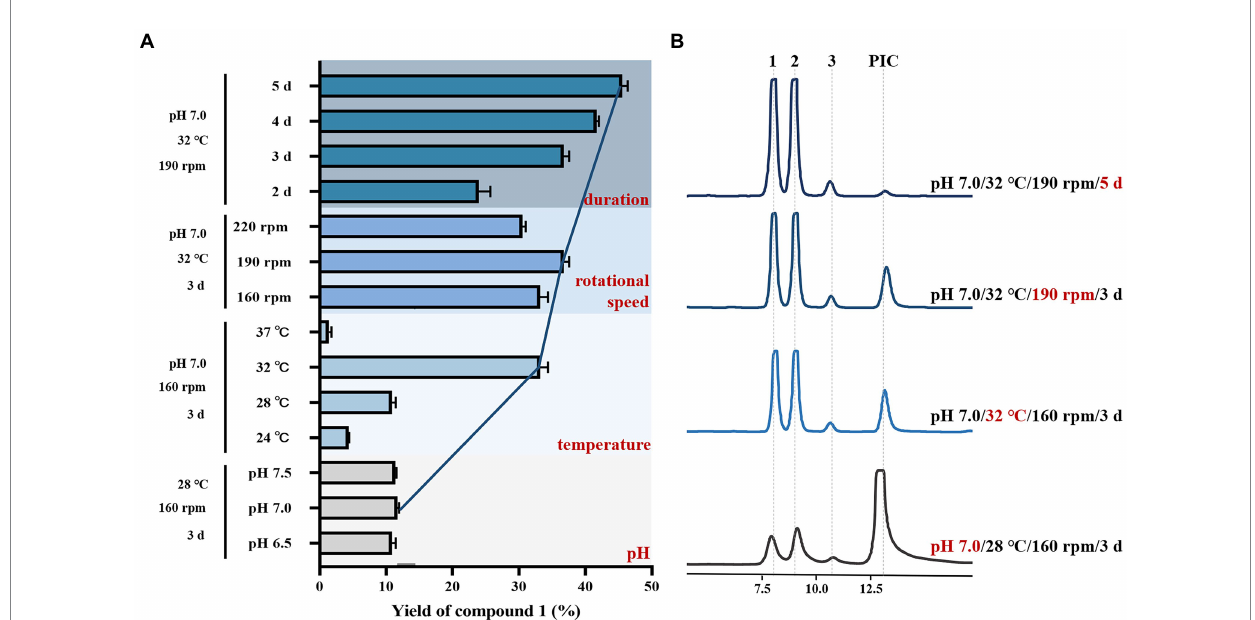
FIGURE 5 Optimization of the fermentation conditions for biotransformation of PIC by Beauveria bassiana . (A) Yield of 1 under different fermentation conditions, and the data represent the mean ± SEM, n = 3. (B) HPLC chromatograms of crude extract of biotransformation